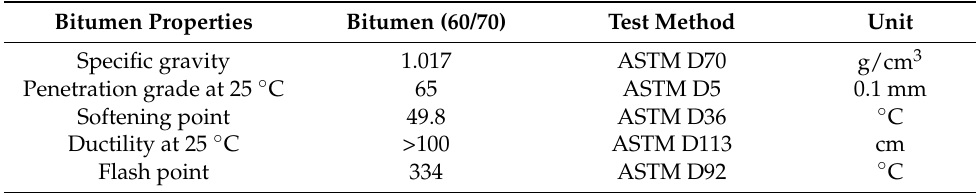
Table 1. Bitumen Properties.